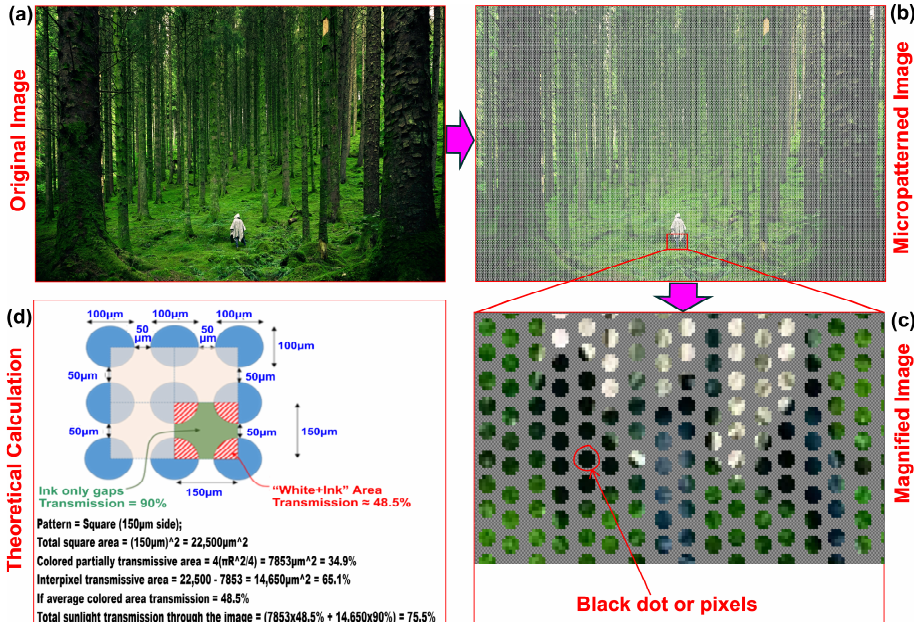
Figure 15. Formation of micropatterned image and light transmission calculation through it. ( a ) A randomly selected high-resolution nature image (reproduced and modified from [139]), ( b ) micropatterned image, ( c ) a magnified view of the micropatterned image, and ( d ) theoretical calculation of light transmission through a micropa tt erned image (reproduced and modi fi ed from [138]).